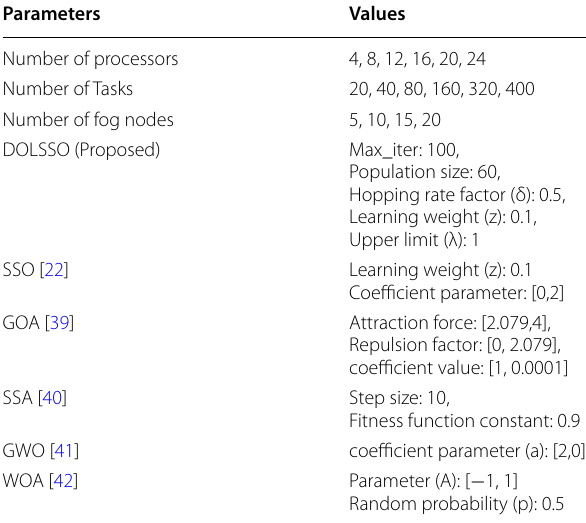
Table 1 Simulation parameters for experimentation